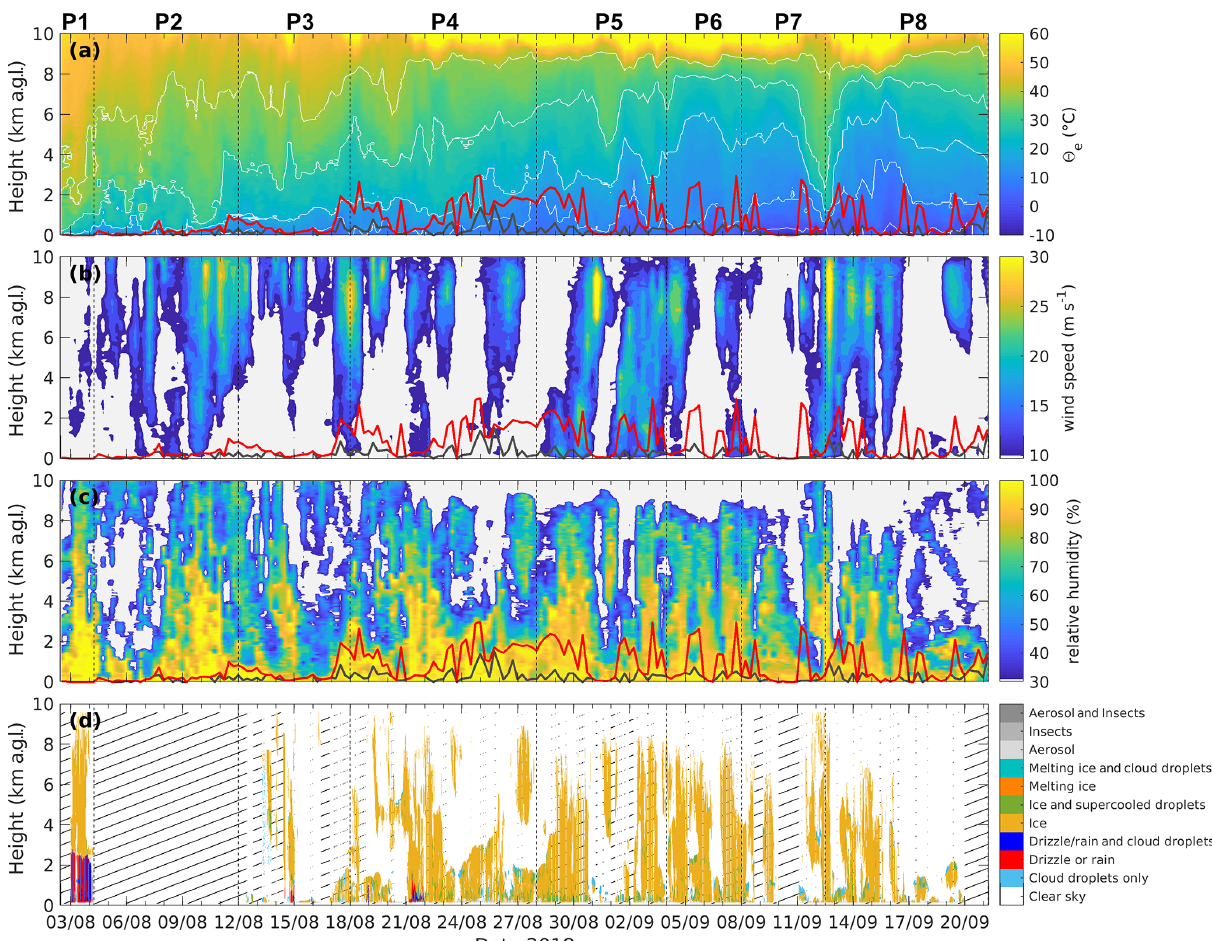
Figure 7. Contour plots of (a) equivalent potential temperature, (b) wind speed, (c) RHw measured by radiosondes, and (d) cloud target classification from the Cloudnet algorithm. The red lines in panels (a) – (c) show the main inversion base height, and the grey lines the surface mixed layer depth identified from radiosonde data. Dashed vertical lines mark the identified key periods. Striped grey areas in panel (d) represent times of missing